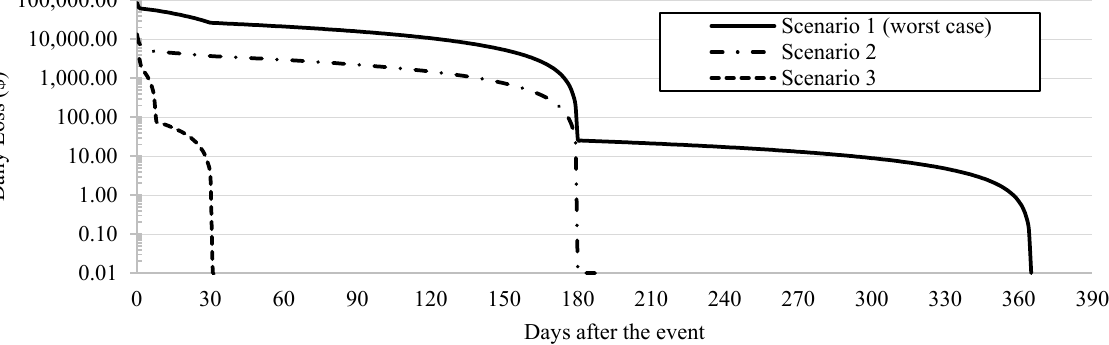
Figure 14. Change in operational cost overtime for the first three scenarios.